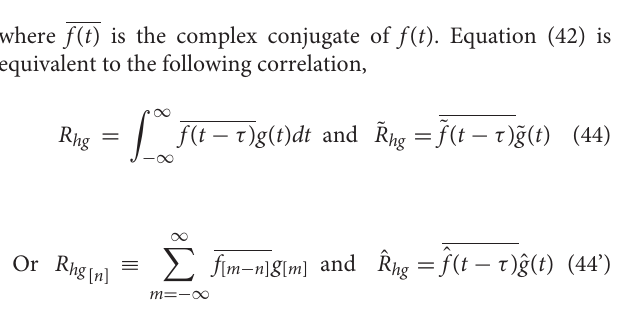
and minor radii of the ellipsoid are R x 200 mm, and the normal force is P z